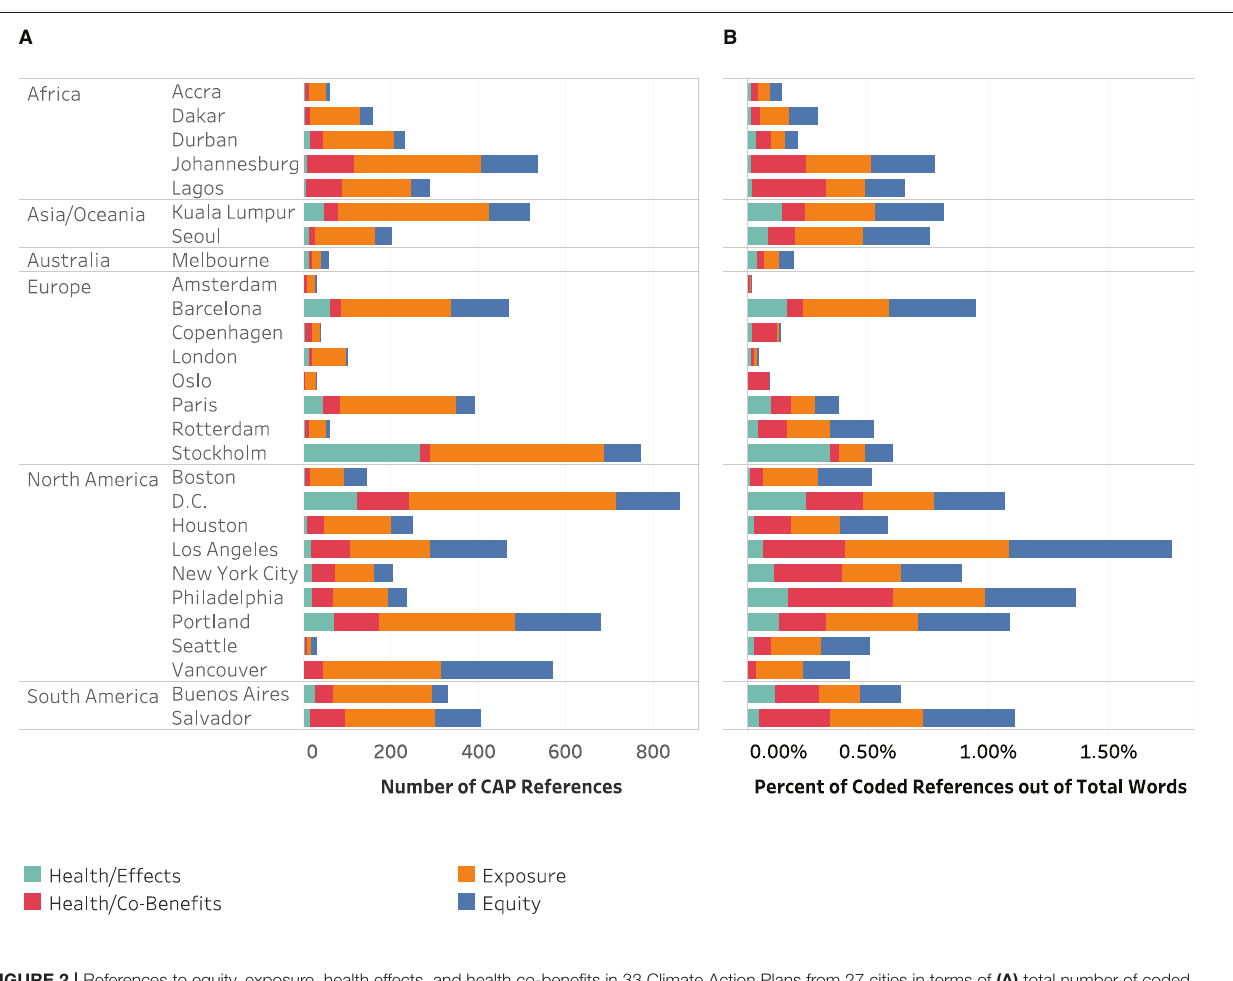
FIGURE 2 | References to equity, exposure, health effects, and health co-benefits in 33 Climate Action Plans from 27 cities in terms of (A) total number of coded references and (B) percentage of coded references out of the total number of words in each CAP